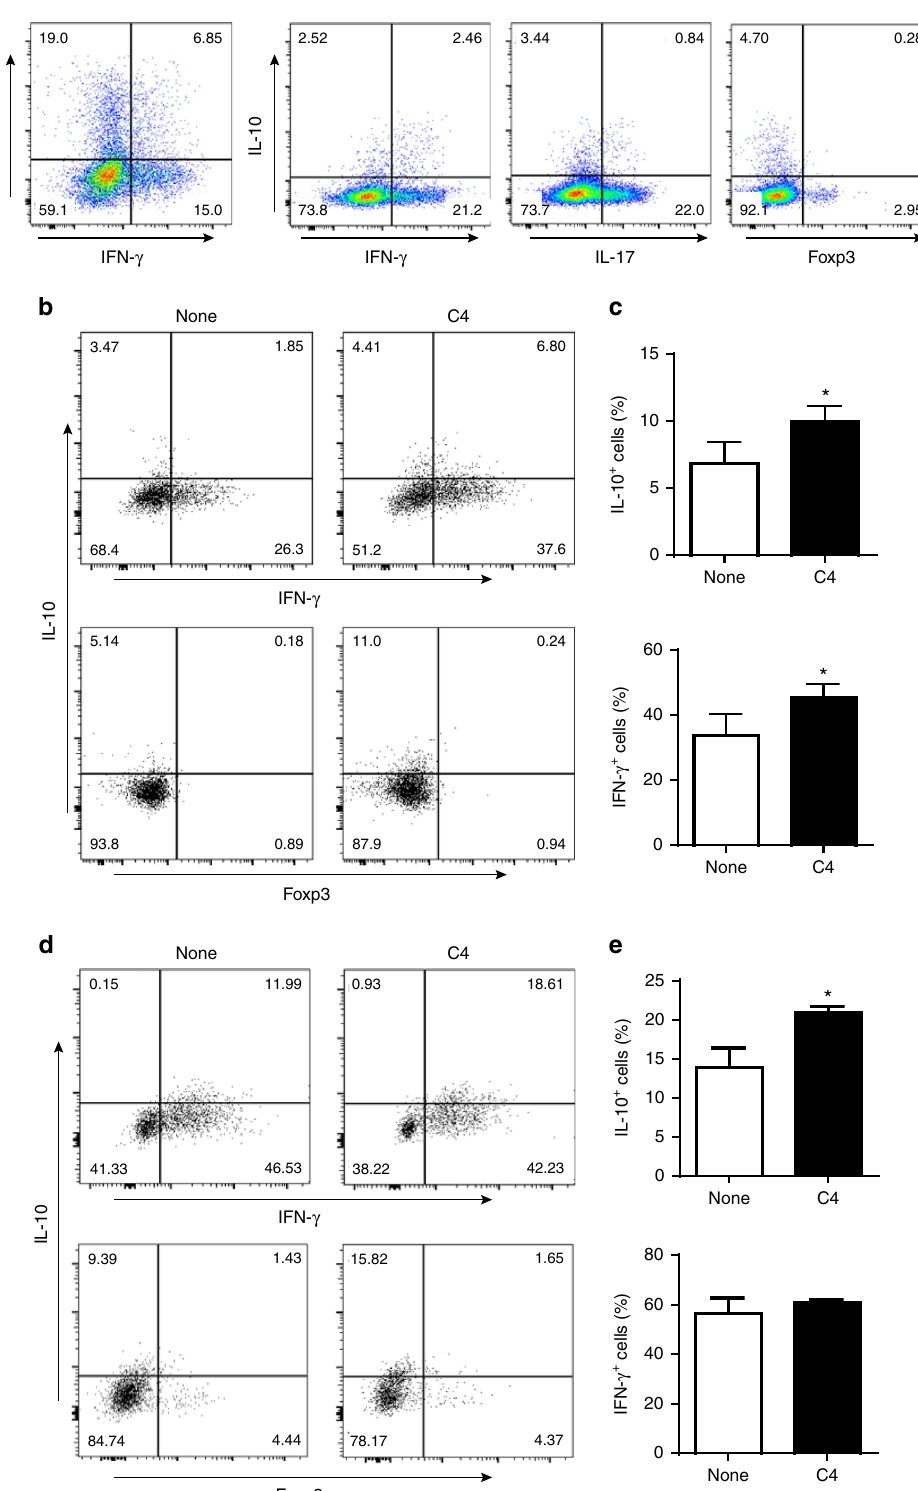
Fig. 3 Th1 cells express IL-10 in in fl amed mucosal lesions and SCFAs induce T-cells IL-10 production in vivo. a 1 × 10 6 naïve CBir1 Tg T-cells were